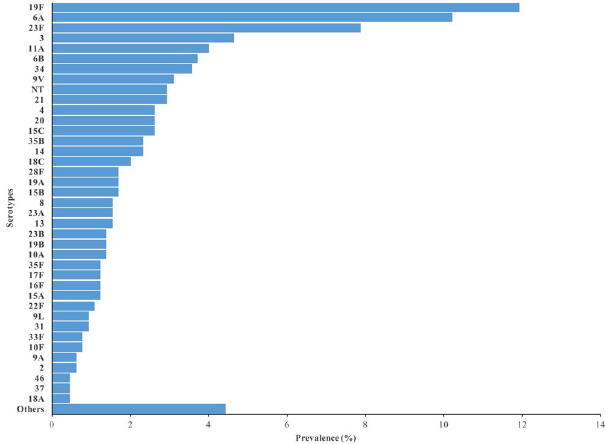
Figure 1. Nasopharyngeal carriage prevalence of individual Pneumococcal serotypes in Kumbotso (rural setting), Nigeria.